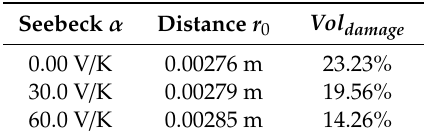
Table 10. The irreversible thermal damage of lipoma tumor with various Seebeck coe ffi cients and at voltage V = 84V and time t = 210